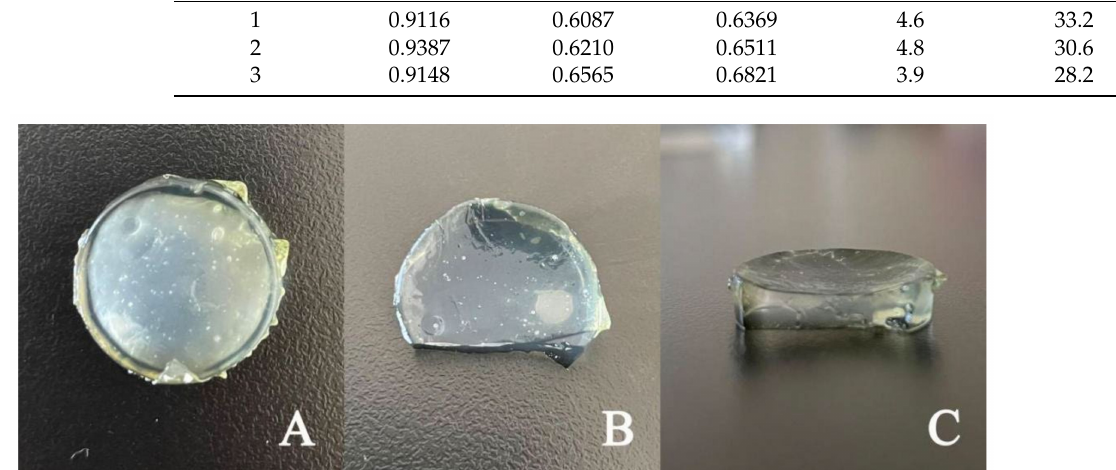
Figure 9. The state of combined application of hydrogels and nanofiber membranes. ( A ) Fit state after complete wetting (The nanofiber membrane is in the lower layer), ( B ) fit state after complete wetting (The nanofiber membrane is in the upper layer), ( C ) cross-section angle (The nanofiber membrane is in the upper